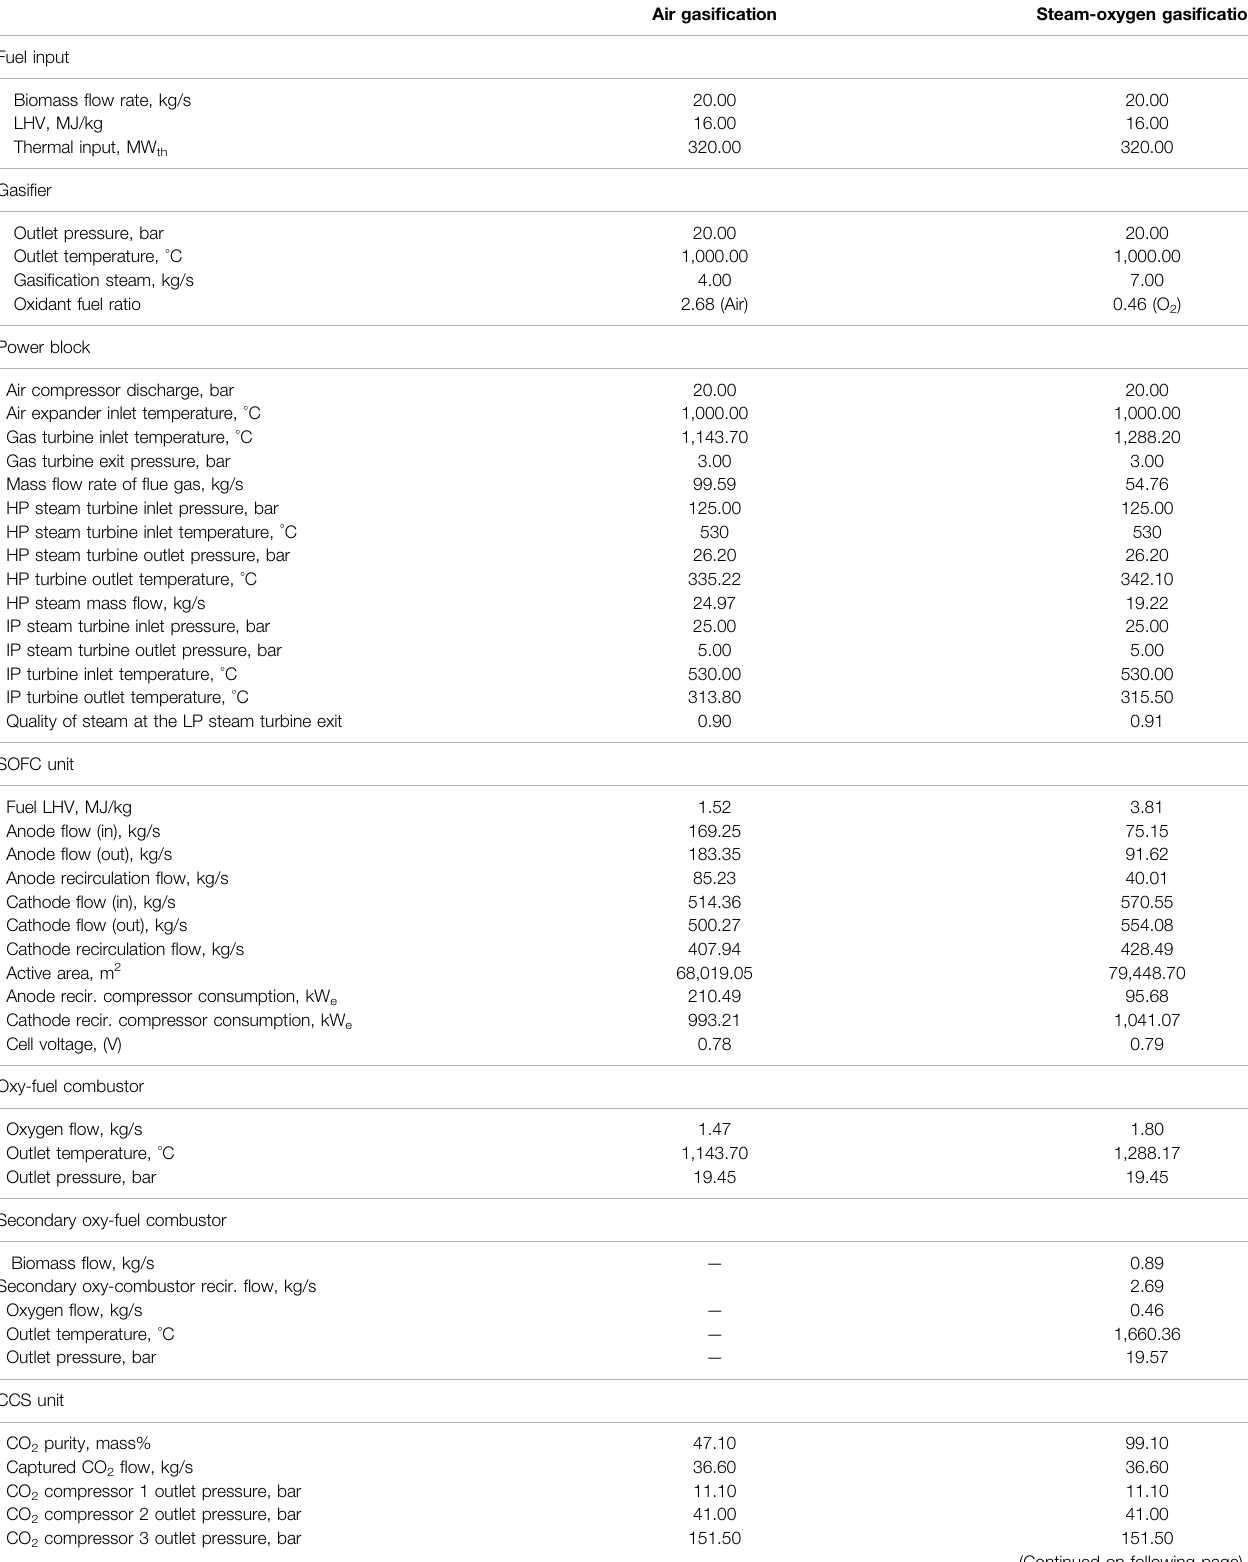
TABLE 6 | Model results of the air gasi fi cation case — a comparison with the steam-oxygen gasi fi cation